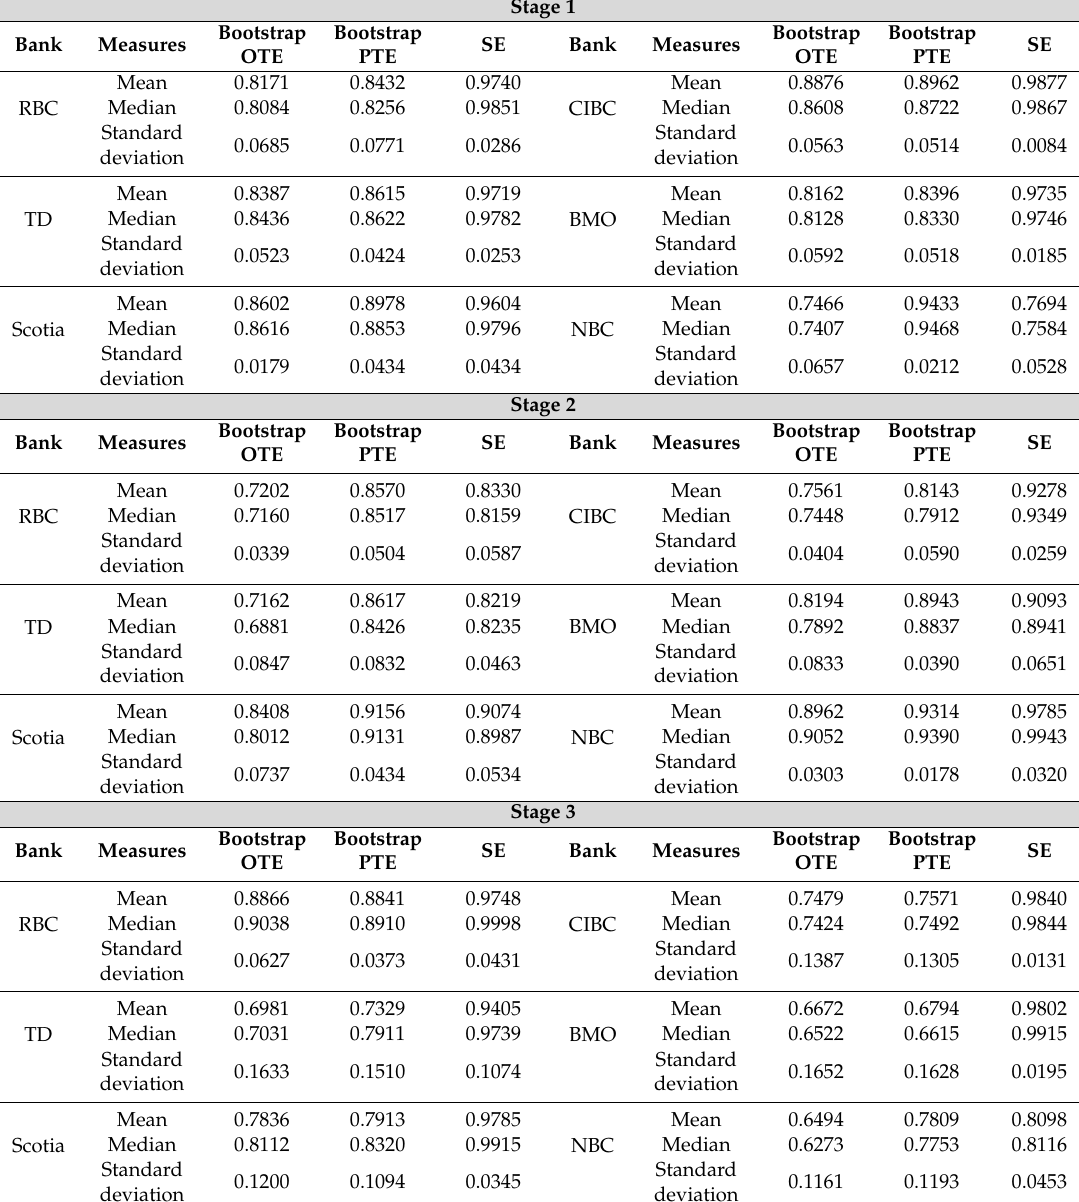
Table 6. Bootstrap OTE, bootstrap PTE, and SE for the banks over the study period (2000–2017). Stage